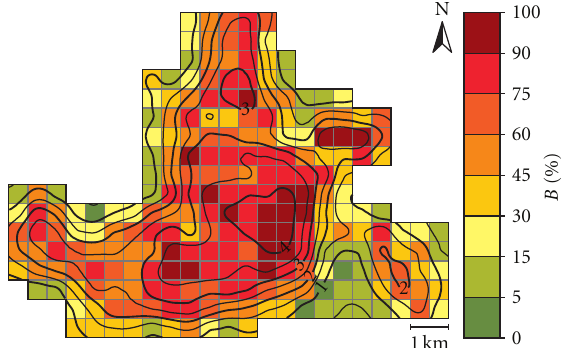
Figure 5: Spatial distribution of the built-up ratio (%) and the modelled annual mean UHI intensity ( ◦ C) in the study area of Novi